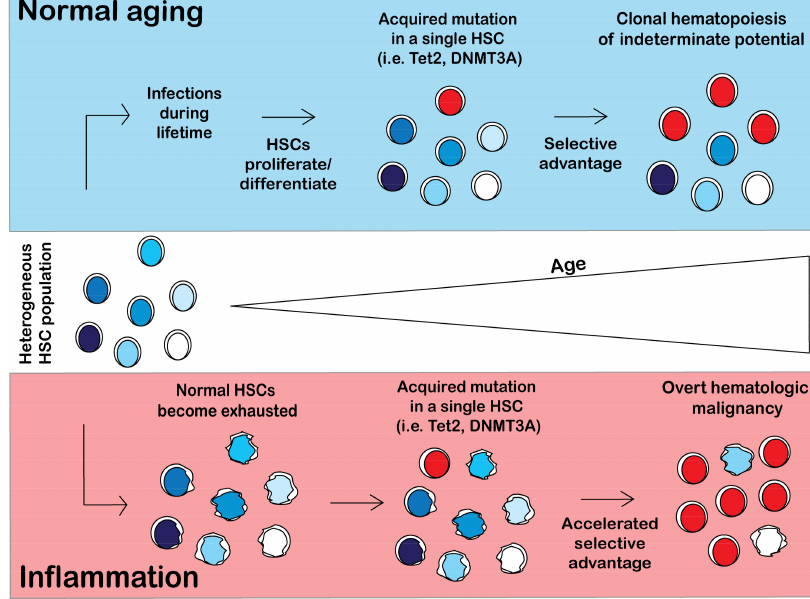
Figure 3. Model of clonal hematopoiesis in normal and inflammatory conditions. In a normal person, hematopoietic stem cells (HSCs) will differentiate and self-renew over the course of a lifetime to replenish the blood system. HSCs will acquire somatic mutations as a result of proliferative stress. Certain HSC mutant clones (i.e., Tet2, DNMT3A) will acquire a selective advantage over wild type (WT) HSCs, resulting in clonal hematopoiesis. However, in an inflammatory environment, normal HSCs are exhausted and have impaired fitness. HSCs will acquire somatic mutations and will likely have an accelerated selective advantage over the exhausted HSCs, resulting in an earlier onset of CHIP (not illustrated in figure) and possibly in hematologic